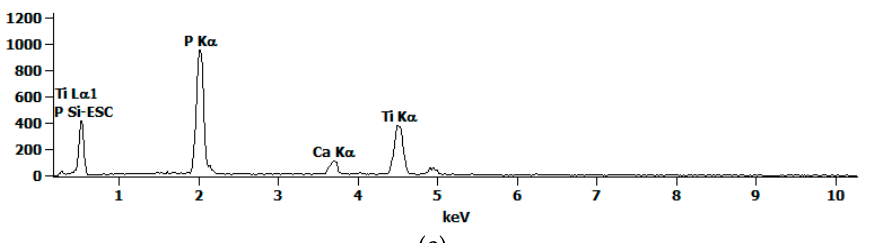
Figure 3 . SEM pictures ( a – d ) and EDS spectrum ( e ) of the porous coating formed on CP Titanium Grade 2 after PEO treatment at a voltage of 450 V in 600 g Ca(NO 3 ) 2 ·4H 2 O in 1000 mL H 3 PO 4 electrolyte. Magnifications: ( a ) 500×, ( b ) 1000×, ( c ) 5000×, ( d ) 10,000×.